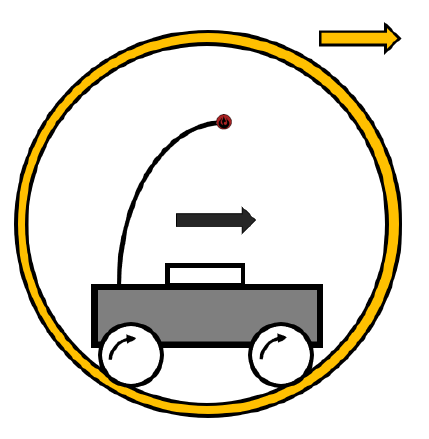
Figure 2. Principle sketch of a Hamster ball mechanism.